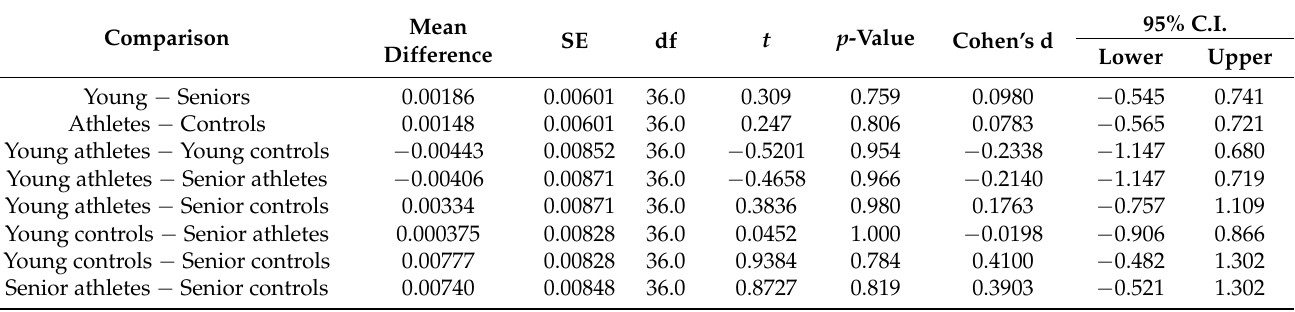
Table 6. ANOVA results for maximum D V .